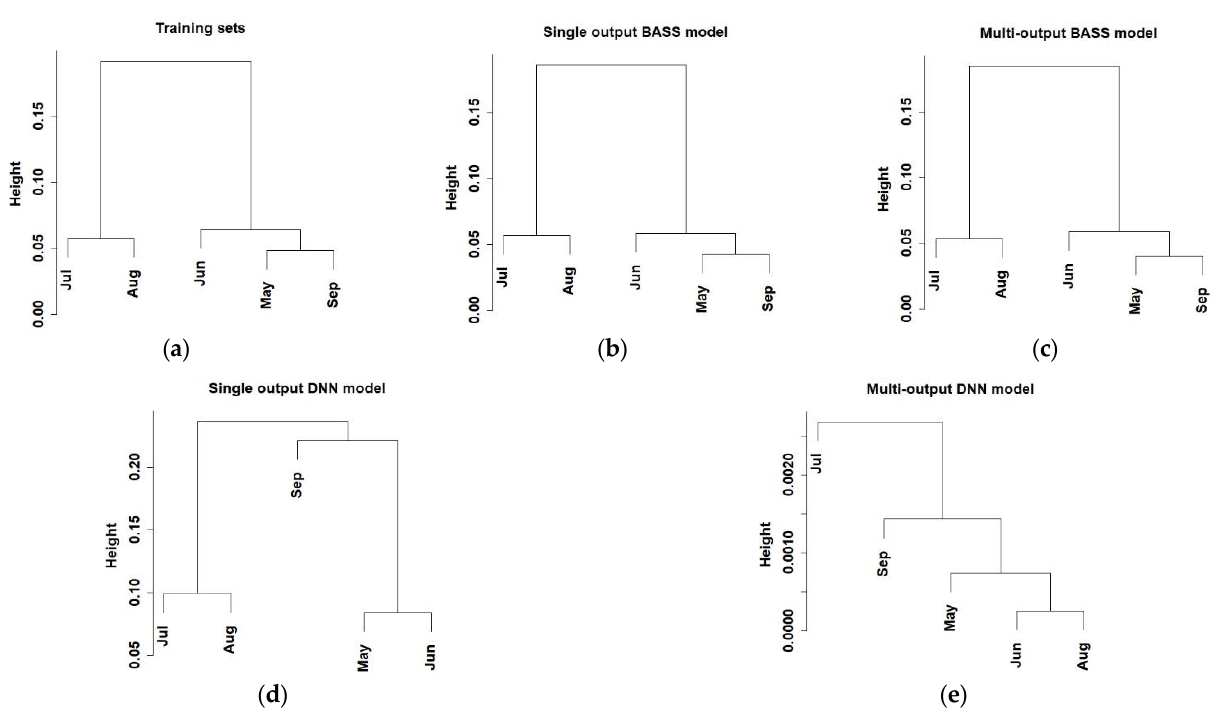
Figure 8. Dendrogram of monthly cooling energy for the training set and four machine learning models.